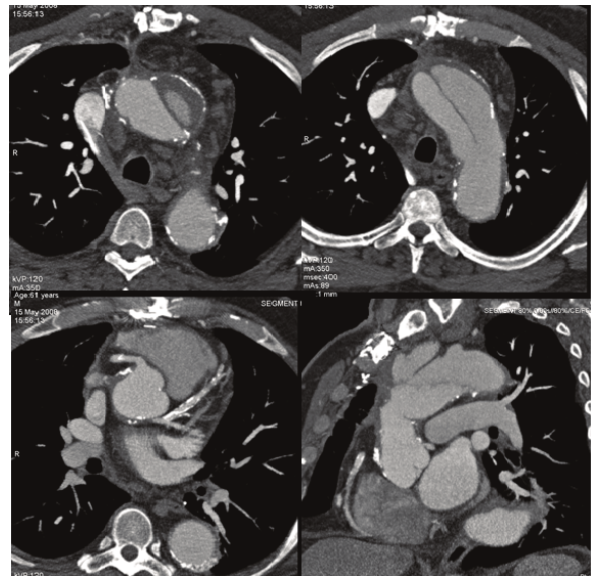
Figure 7: Type A Aortic dissection. CT is able to evaluate the flap, true and false lumen, the thrombotic material into the false lumen and the relationship of the flap with the thoracic aortic